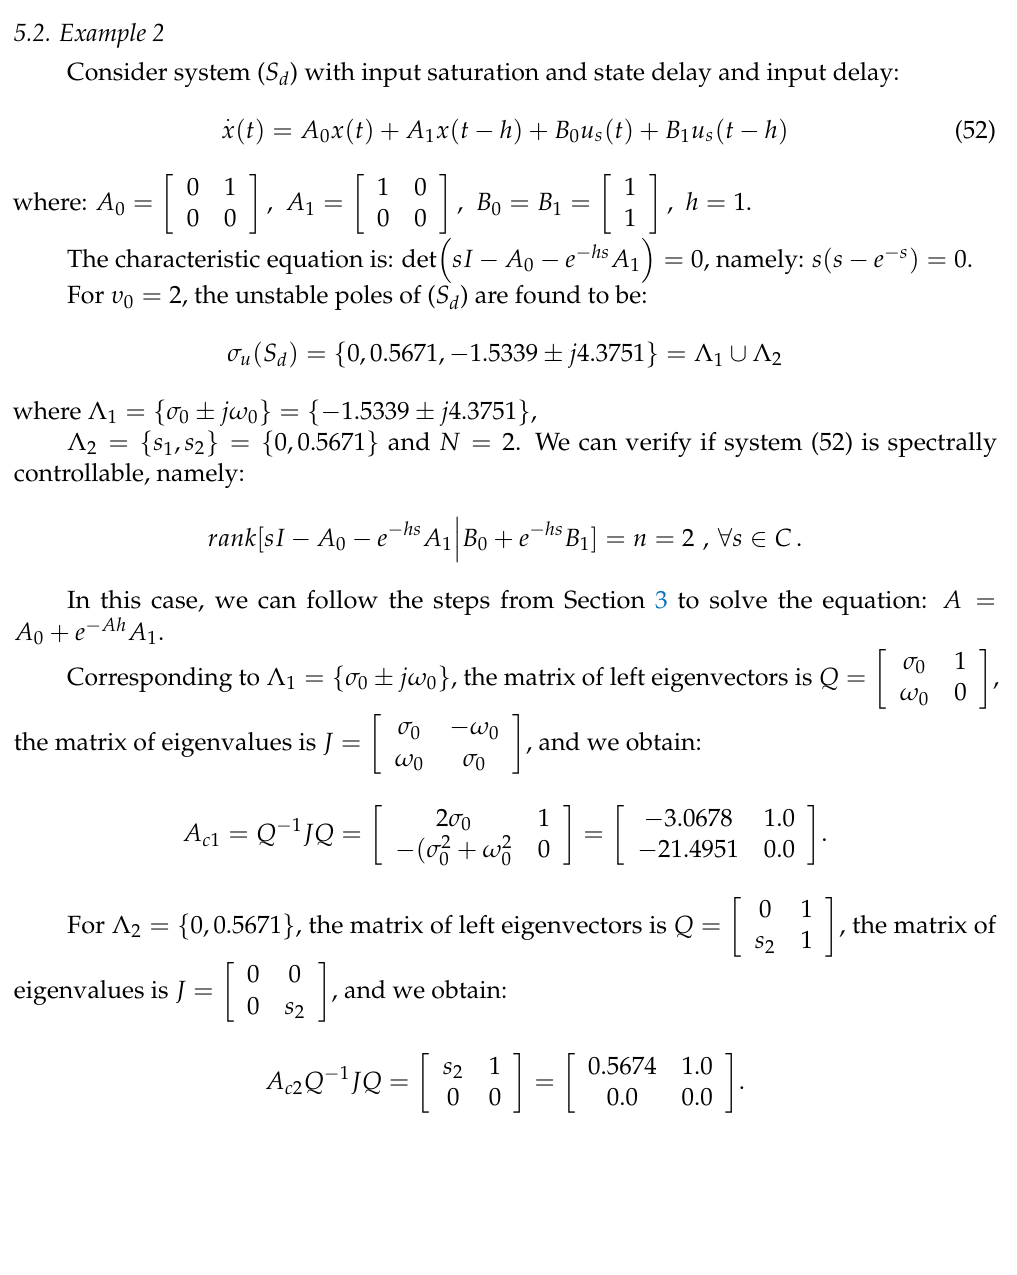
Figure 3. Evolution of the states with 01.0